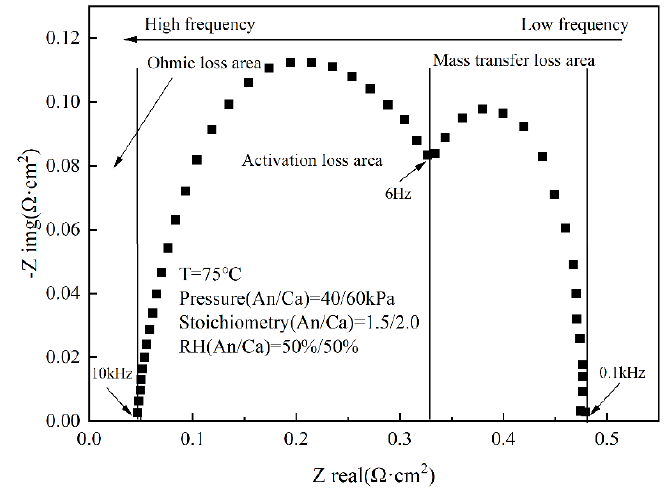
Figure 2. Nyquist diagram of the test fuel cell at 0.6 A/cm 2 .